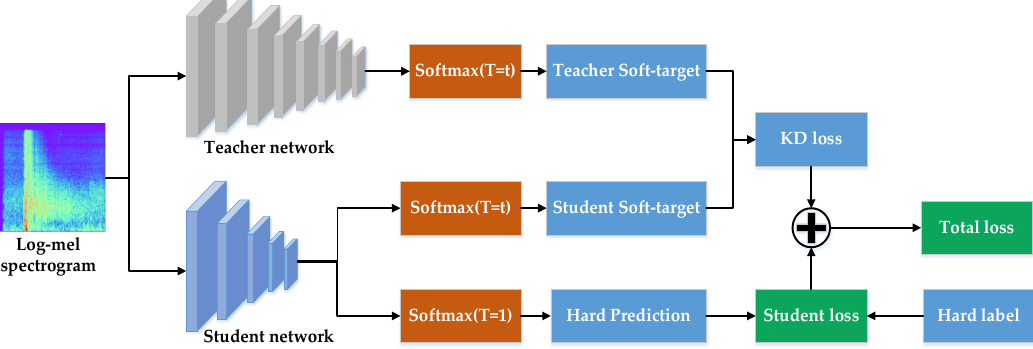
Figure 4. Schematic diagram of the knowledge distillation network.